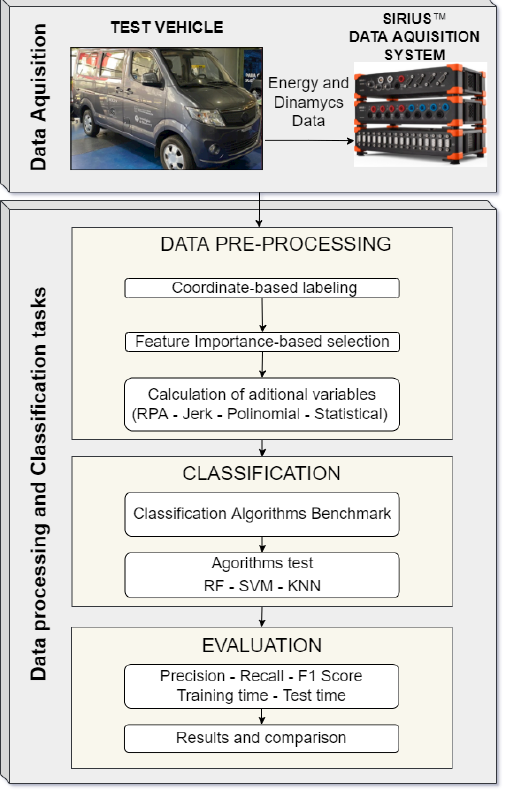
Figure 3. Experimentation and algorithm design process (provisional).